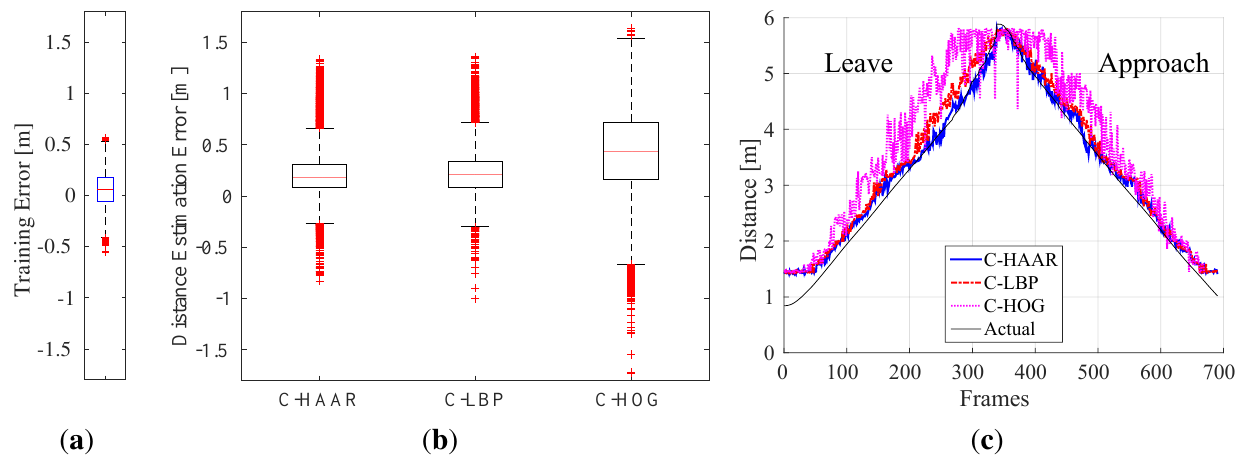
Figure 16. ( a ) Training error distribution for distance estimation; ( b ) distribution of distance estimation error for each method; ( c ) distance estimations during a leaving motion followed by an